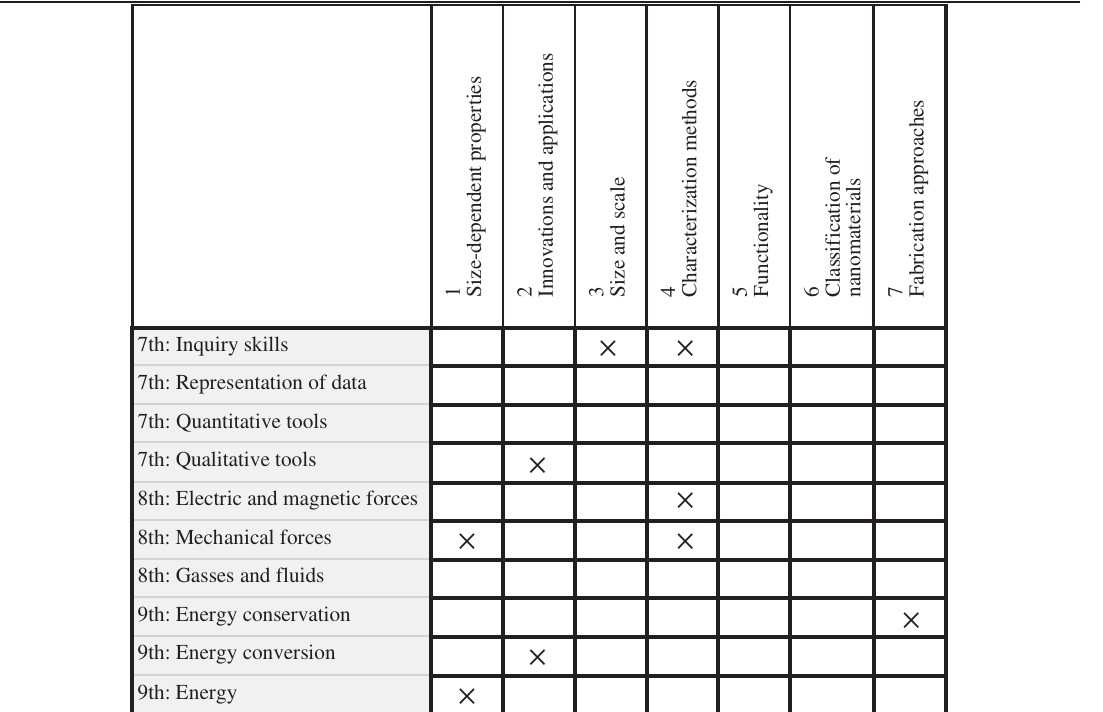
TABLE II. Connections between middle school physics curricular topics (left) and NST essential concepts (top) that were found to be “ strong ” by a group of scientists and validated as suitable by a middle school